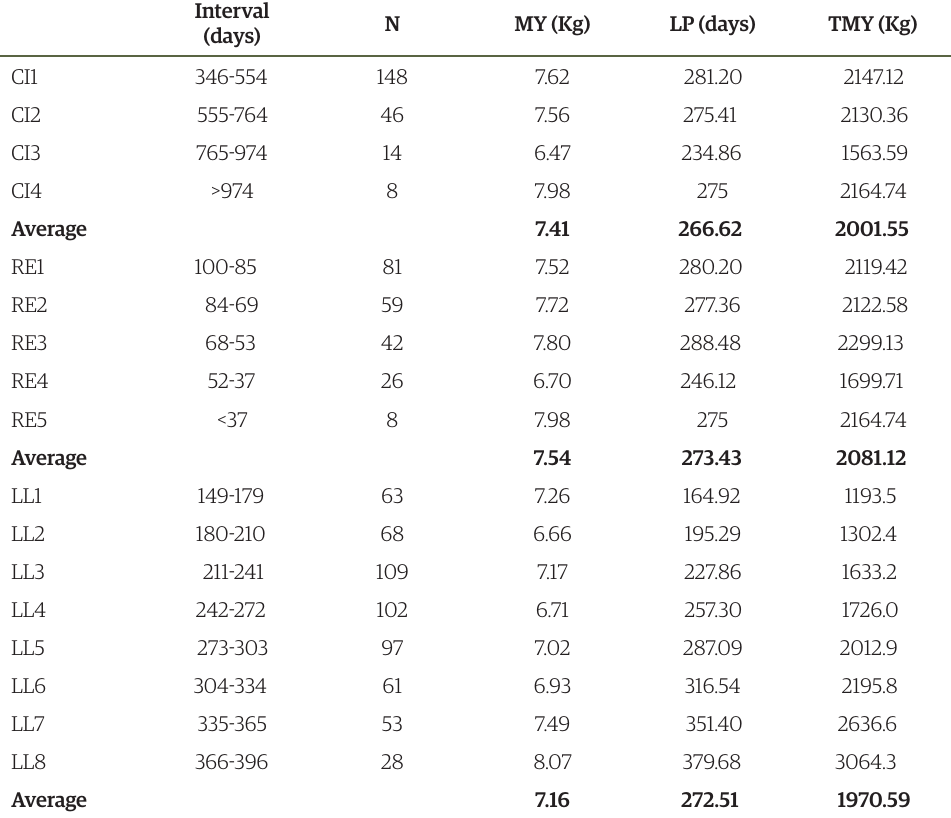
Table 3. Averages for milk yield (MY), lactation period (LP) and total milk yield (TMY) according to classes for calving interval (CI), reproductive efficiency (RE) and lactation period